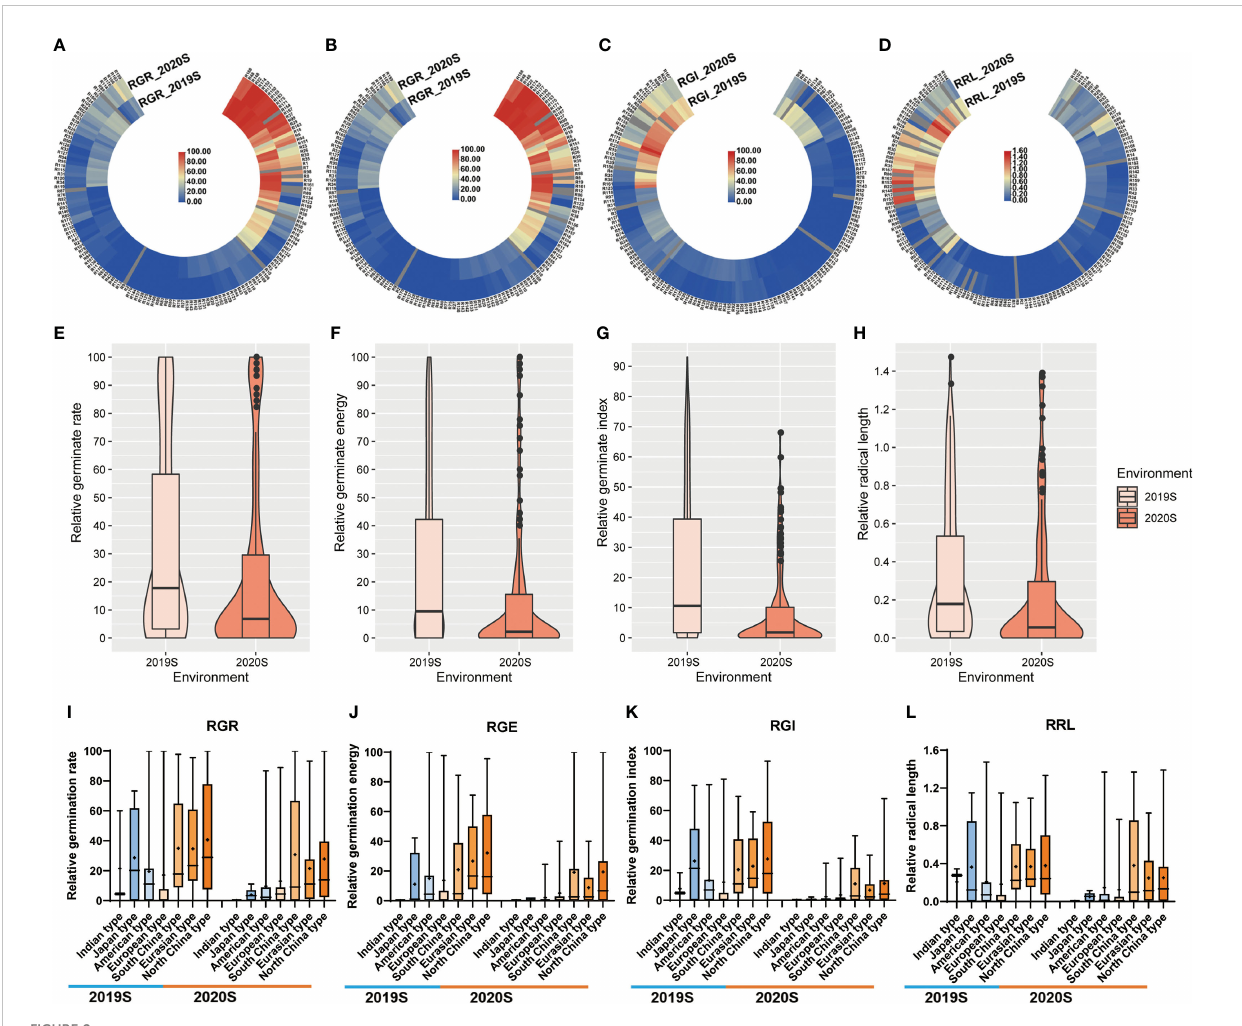
FIGURE 2 Heatmap, violin and box plots showing the phenotypic distribution of RGR, RGE, RGI and RRL among cucumber accessions grown under two environments. (A – D) Heatmap depicting the repeatability of the four germination indices, i.e., RGR, RGE, RGI and RRL. Blue and red bars represent accessions sensitive and tolerant to LTs, respectively, with the color intensity indicating the level of sensitivity or tolerance. (E – H) Violin and box plots depicting the distribution of the germination indices in two experiments. (I – L) Box plots depicting the distribution of the germination indices in